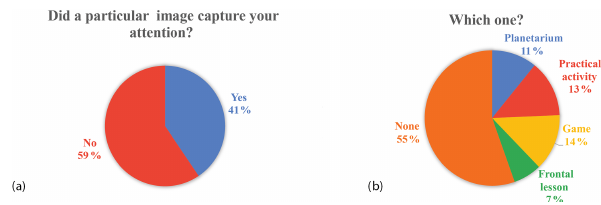
Figure 15. The pie chart in the panel (a) illustrates how much the students think they were captured by an image and the panel (b) shows which